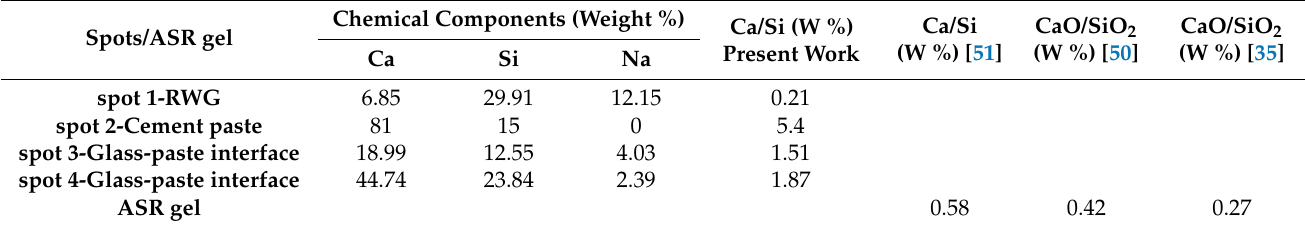
Table 5. SEM-EDS analysis of mortar incorporated with 50% volume content of RWG (MRWG50).